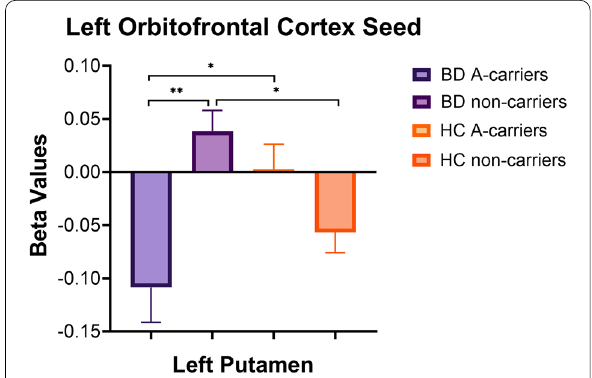
Fig. 4 Interaction between bipolar disorder (BD) diagnosis and CACNA1C rs1006737 on rsFC between left orbitofrontal cortex seed and left putamen. Beta values correspond to Fischer-transformed correlation coefficient values, adjusted for age, sex, and race. Error bars denote standard error of the mean. HC healthy controls. * p < 0.05, ** p <